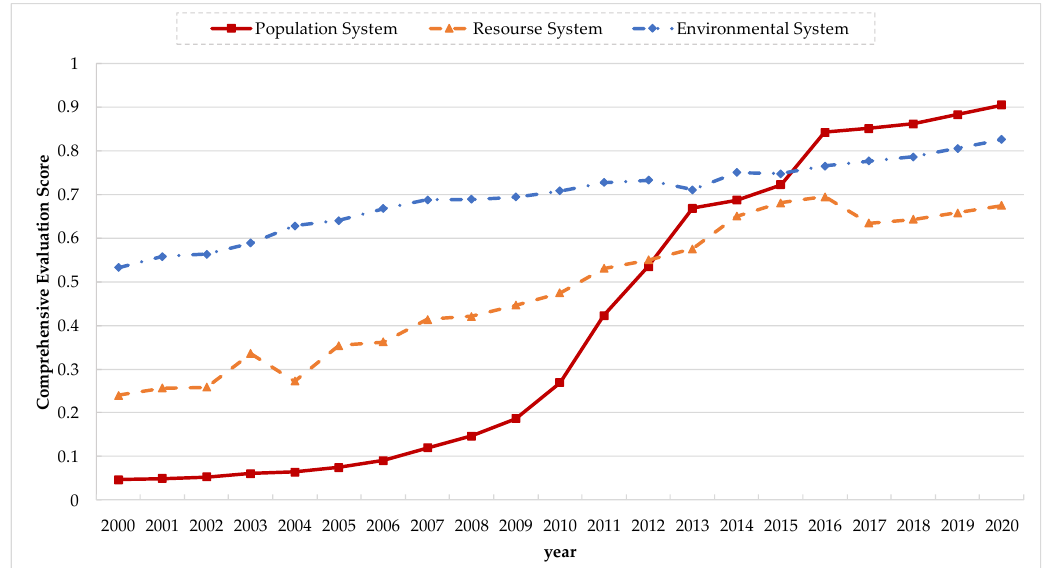
Figure 3. Time evolution of the comprehensive evaluation score of each system in Jiangsu.